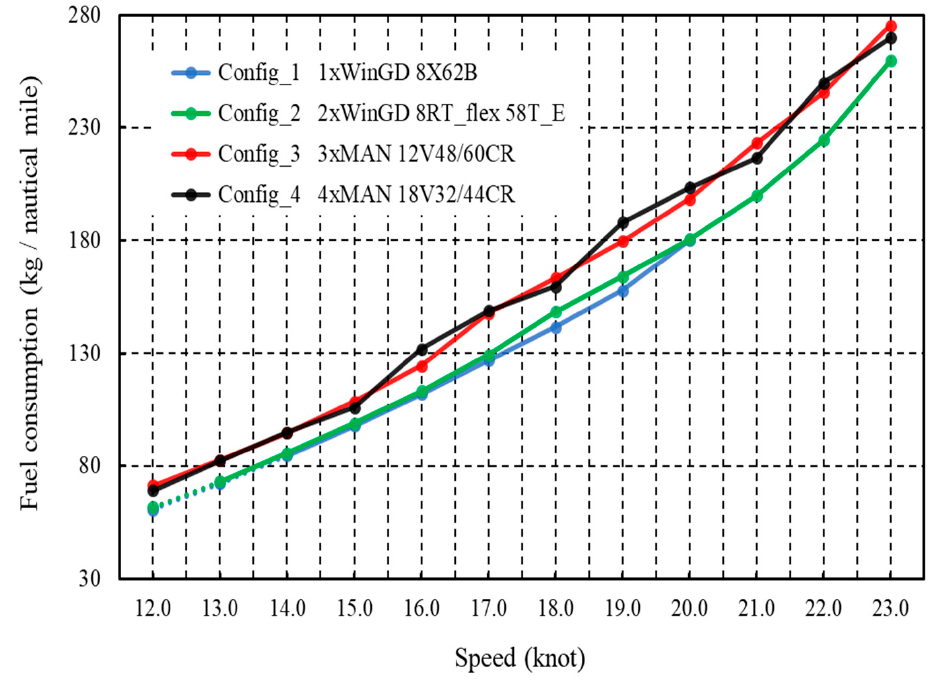
Figure 16. Fuel consumption depending on sailing